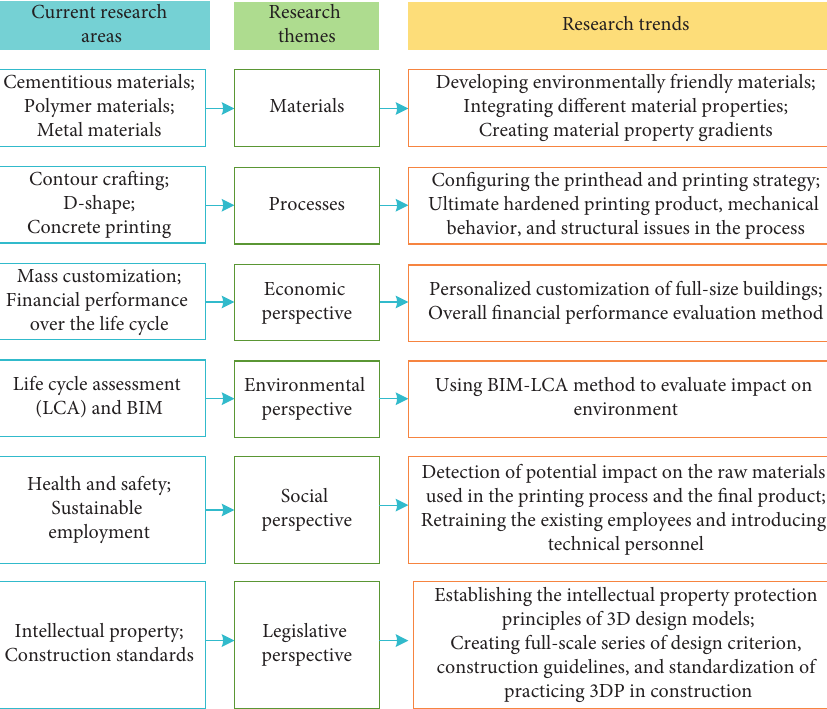
Figure 5: Framework for the future development of 3DP in